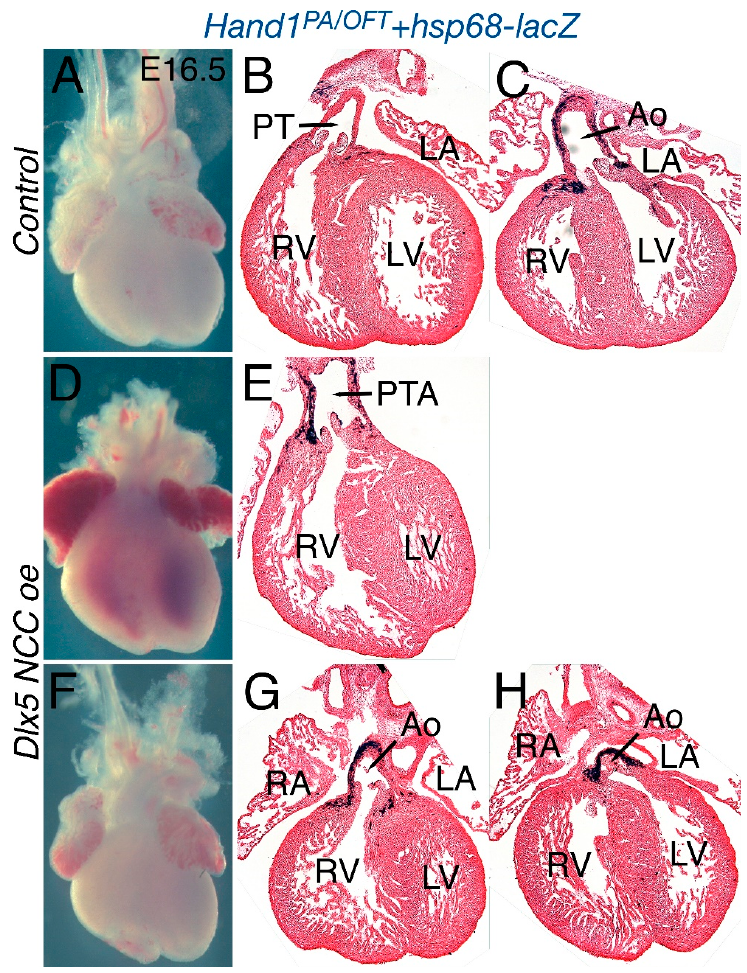
Figure 3. Phenotypic analysis of Dlx5 NCC oe hearts at E16.5. Whole mount ( A ) and frontal sections ( B and C ) of control ( CAG-CAT-Dlx5 ; Hand1 PA/OFT - lacZ ) heart showing patent septation and proper alignment of the pulmonary trunk (PT) and aorta (Ao) with the right (RV) and left (LV) ventricles. Wholemount Dlx5 NCC oe hearts at E16.5 reveal persistent truncus arteriosus (PTA, D and E ) or double outlet right ventricle ( F – H ) wherein the aorta is connected to both RV: right ventricle and LV; left ventricle, RA: right atria, LA: left atria.